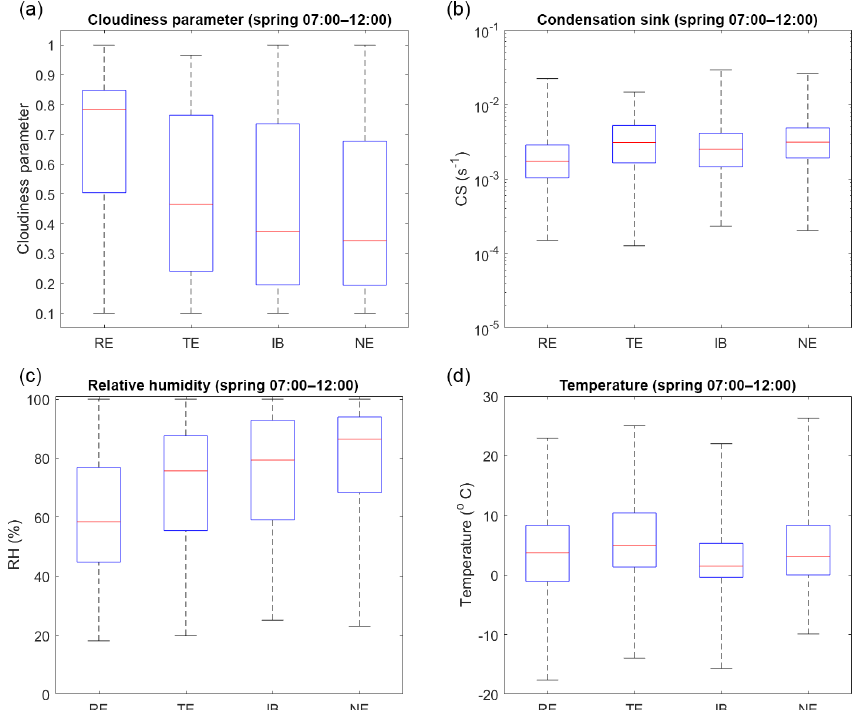
Figure 5. (a) Cloudiness parameter, (b) condensation sink, (c) relative humidity and (d) temperature on different days classified with the new classification method for spring (March–May) of 2006–2016 during the maximum NPF window (07:00–12:00). The acronyms RE, TE, IB and NE stand for regional event, transported event, ion burst and non-event. The red line represents the median of the data and the lower and upper edges of the box represent the 25th and 75th percentiles of the data. The lines extending from the central box represent the minimum and the maximum of the data.